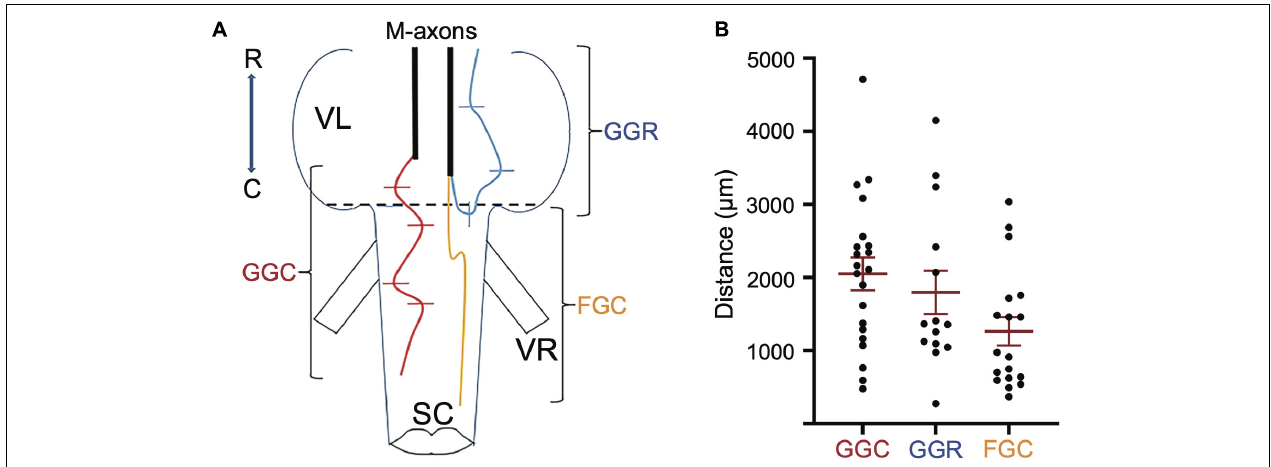
FIGURE 2 | Regrowth of axotomized M-axons. (A) Hindbrain schematic showing three M-axon sprouts and the method of measurement. For each axon, filled with Lucifer yellow, the caudal sprout that had the greatest growth caudally (GGC, red) was measured in segments. In this example, five segments delineated by lines were spliced together to give the GGC. The rostral sprout that had the greatest growth rostrally (GGR, blue) was measured in this example by combining the length of three segments. Measurements were first made when the sprout projected rostrally. The sprout that extended the furthest caudally from the wound site (furthest growth caudally, FGC, orange) was measured as the straight line distance from the caudal edge of the vagal lobes (SML, dashed line) to the end of the sprout. VR, ventral root; VL, vagal lobe; SC, spinal cord; R, rostral; C, caudal. (B) Plots of values (mean ± S.E.M.) for greatest growth caudally (GGC), greatest growth rostrally (GGR), and furthest growth caudally